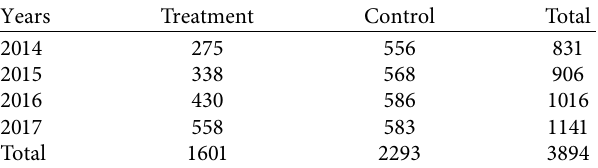
Table 1: Observed